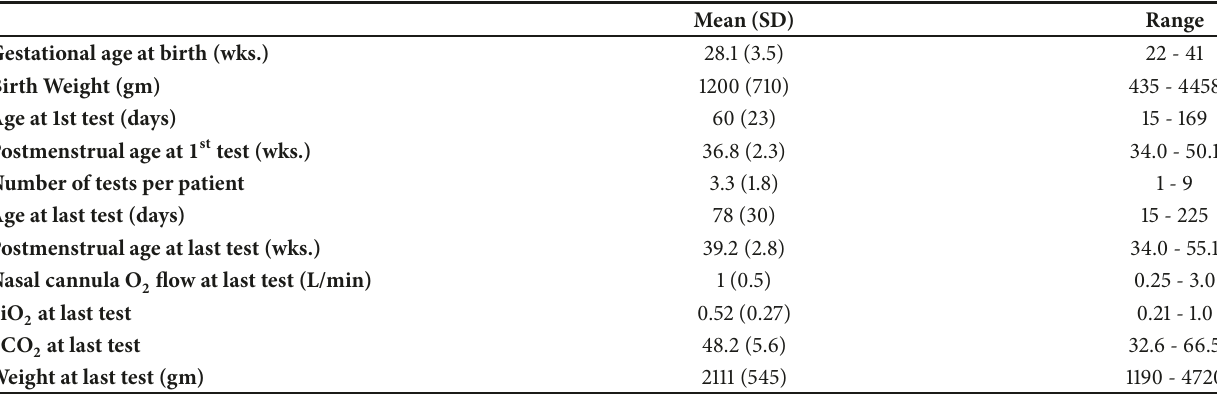
Table 1: Patient Characteristics of infants undergoing StressOx test.